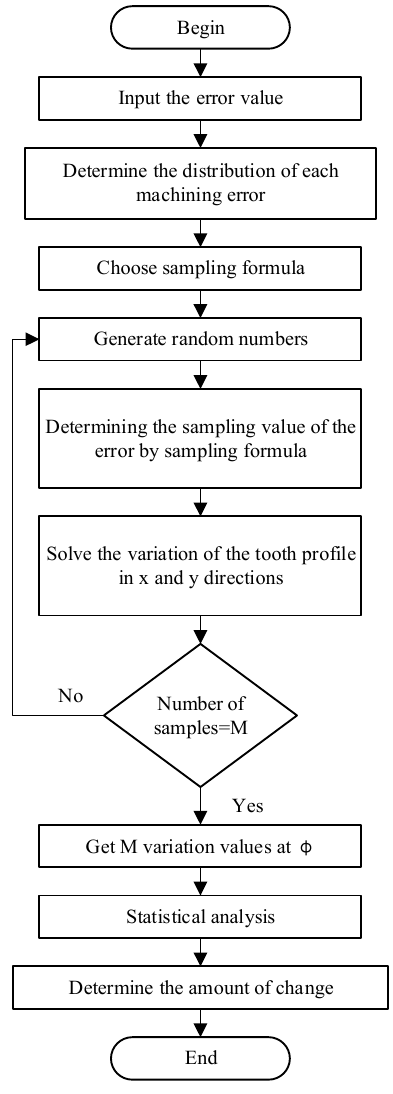
Figure 9. Monte Carlo Simulation Flowchart.